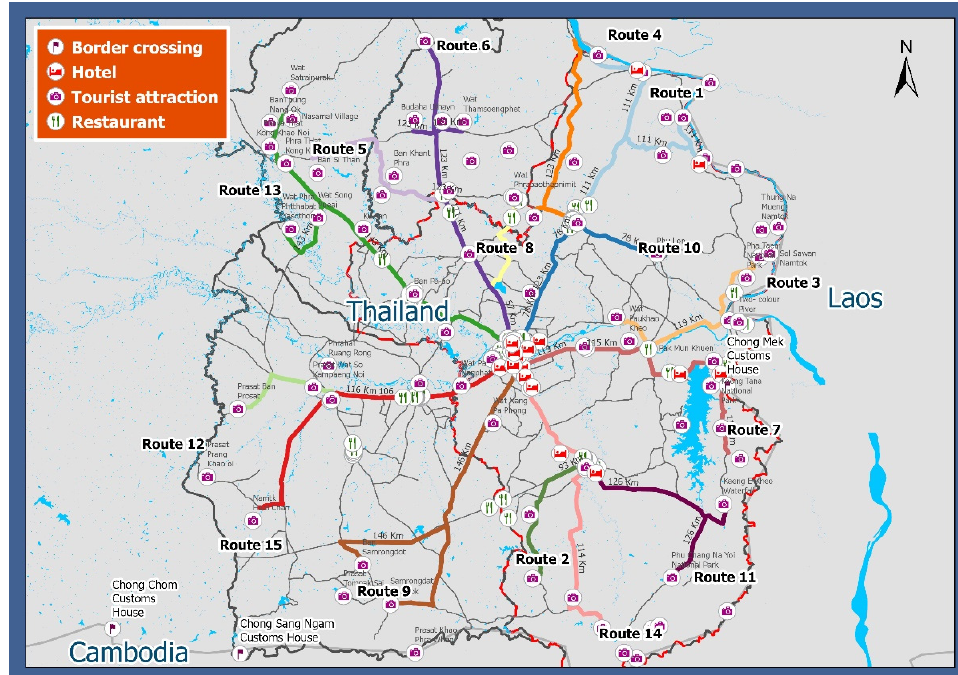
Figure 5. A total of 99 wellness tourism attractions of Ubon Ratchathani.